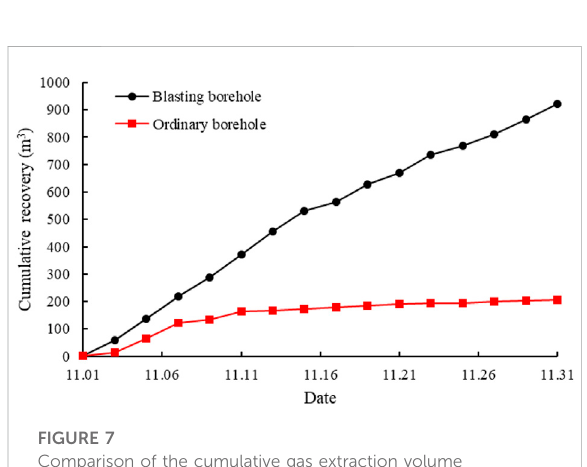
FIGURE 7 Comparison of the cumulative gas extraction volume between blasting boreholes and conventional